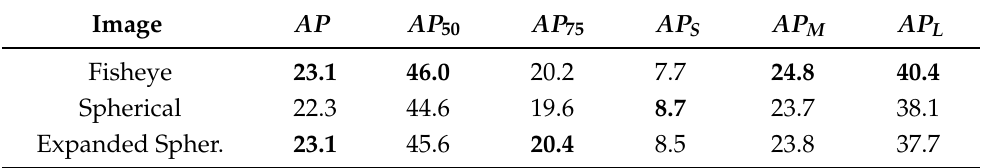
Table 10. Accuracy of different projections of SCat model on the WoodScape.